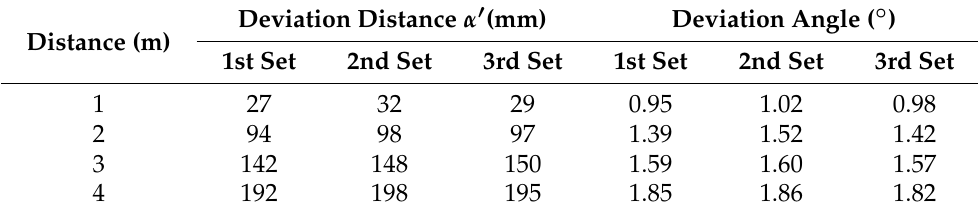
Table 4. Results of straight line motion experiment in legged mode.